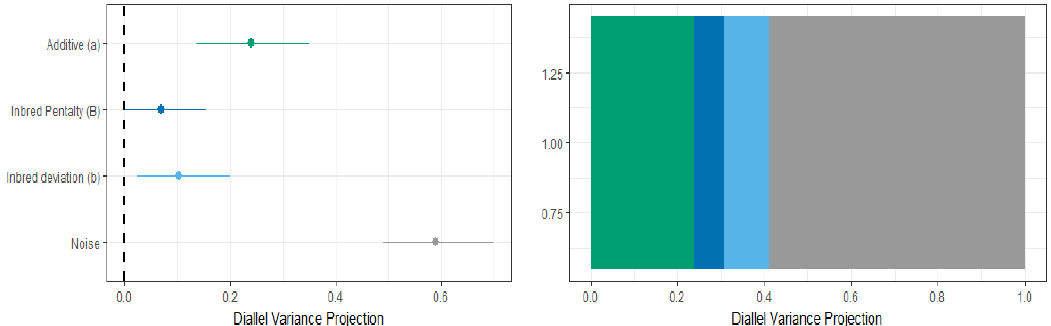
Figure 4. Highest posterior density (HDP) intervals of parent-specific additive effects, parent of origin and inbreeding effect of the 11 parents studied.